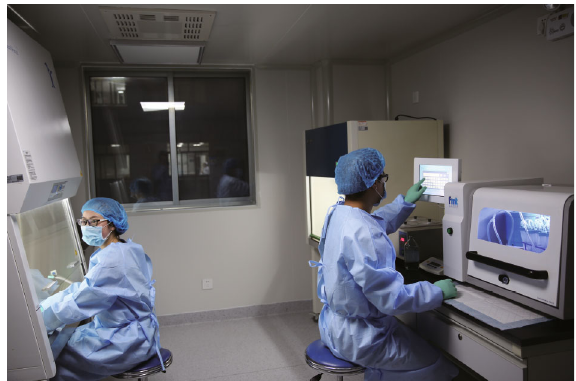
Figure 4. The GMP laboratory for preparation of fecal